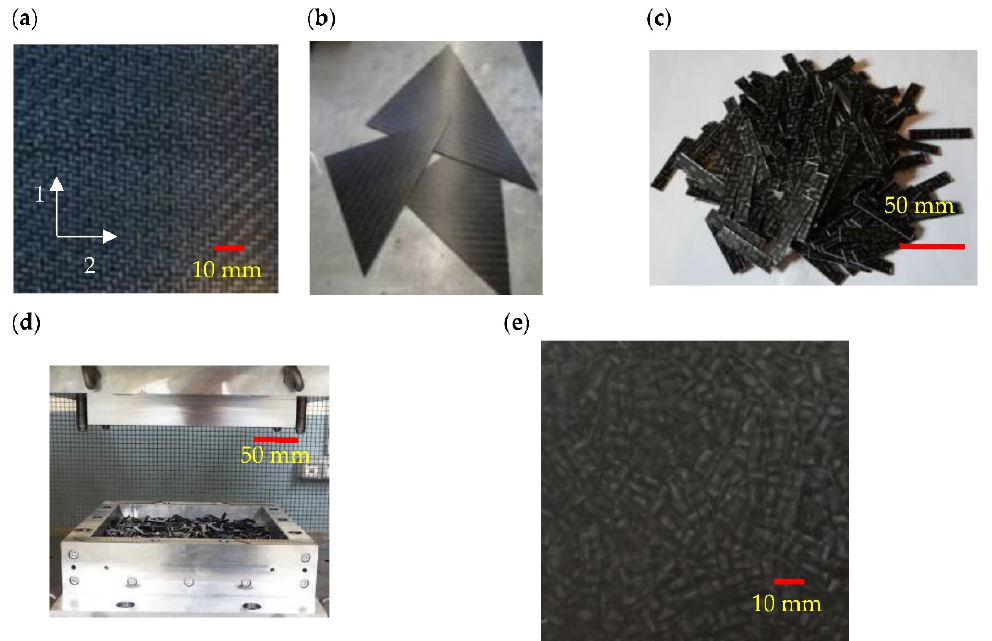
Figure 1. Photographic images of ( a ) initial pre-consolidated composite sheet, ( b ) offcuts/production scrap, ( c ) rectangular shaped grains, ( d ) filling of mould (100% mould coverage) and ( e ) aggregate-reinforced composite panel . Table 1. Configurations of manufactured panel .